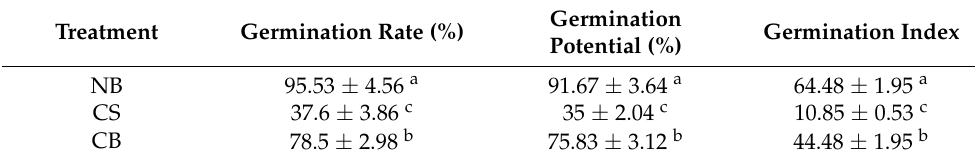
Table 1. Effect of different treatment on the GR, GP, and GI of tomato seeds.